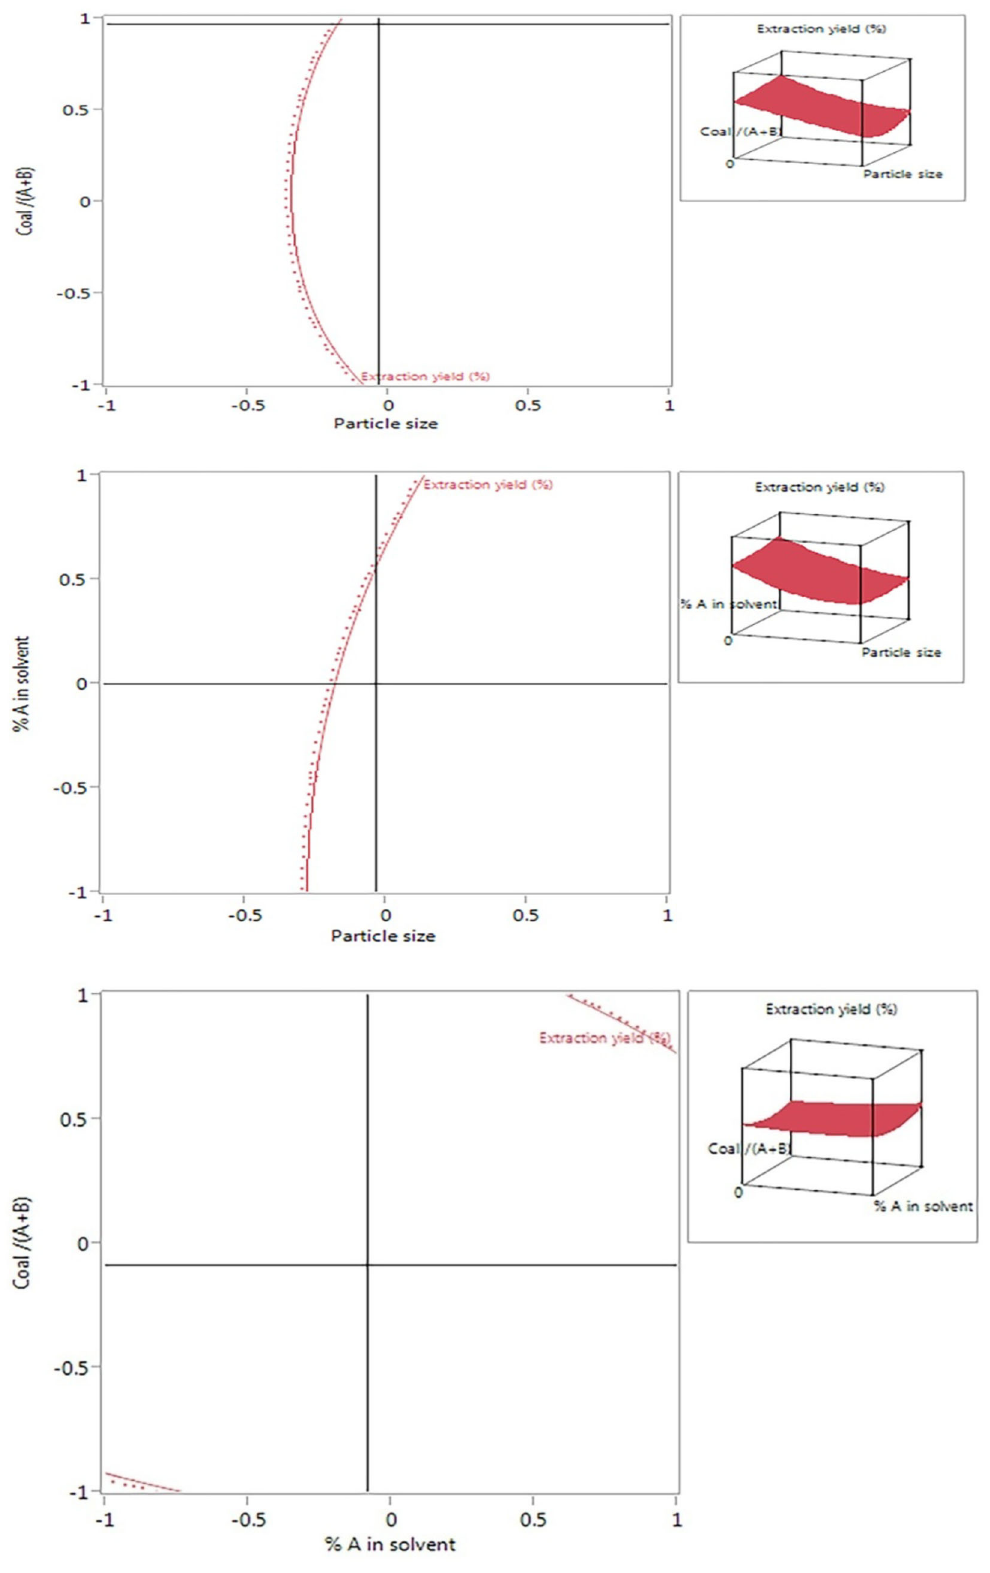
Fig. 6 Contour profilers for the parameters keeping one parameter constant and varying the other two [ A: amount of co-solvent (EDA), A ? B: total amount of co-solvent ? solvent (EDA ?